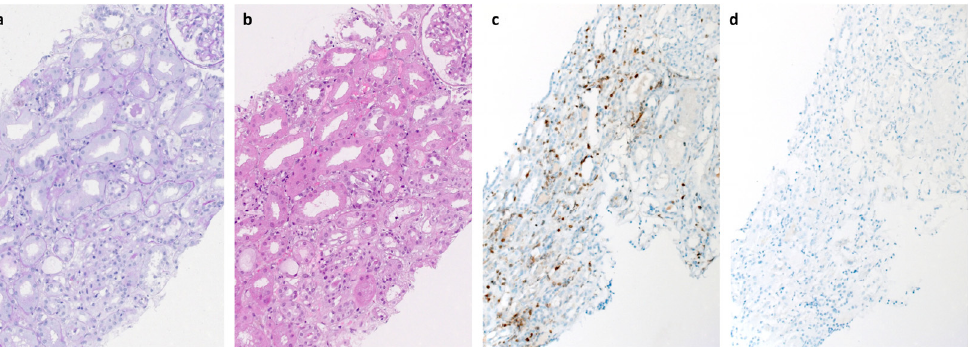
Figure 3. Histologic and immunohistochemical findings of the renal biopsy (day 18). Periodic acid- Schiff (PAS, a ) and hematoxylin and eosin staining (H&E, b ) showed severe diffuse acute tubular epithelial damage, mild interstitial edema, and low-grade focal accentuated lymphocytic interstitial inflammation. Immunohistochemical analysis showed the presence of CD3+ T cells ( c ) whereas CD20+ B cells ( d ) were not